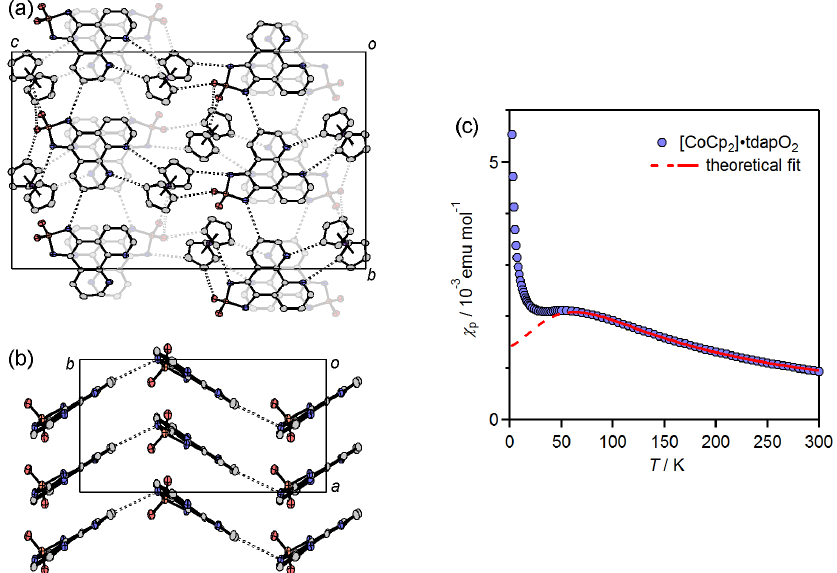
Figure 24. Molecular arrangement of [CoCp